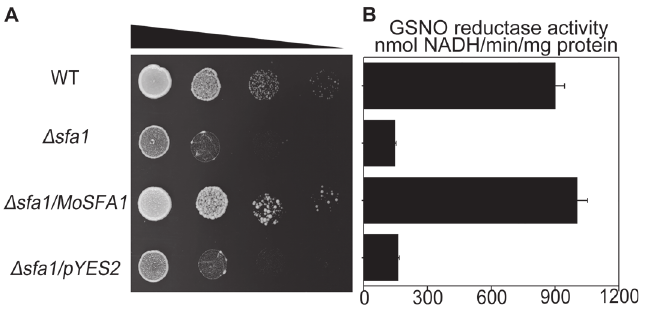
Fig 1. Complementation of the yeast Δ sfa1 mutant by MoSFA1 and GSNO reductase activity in protein extracts. (A) Yeast strains, BY4741(WT), Δ sfa1 , Δ sfa1/ MoSFA1, and Δ sfa1/ pYES2 were spotted onto galactose-containing medium with 1.1 mM formaldehyde at 28°C for 2 days. (B) GSNO reductase activity (mean ± SD) was determined in the tested yeast strains. Error bars represent SD.